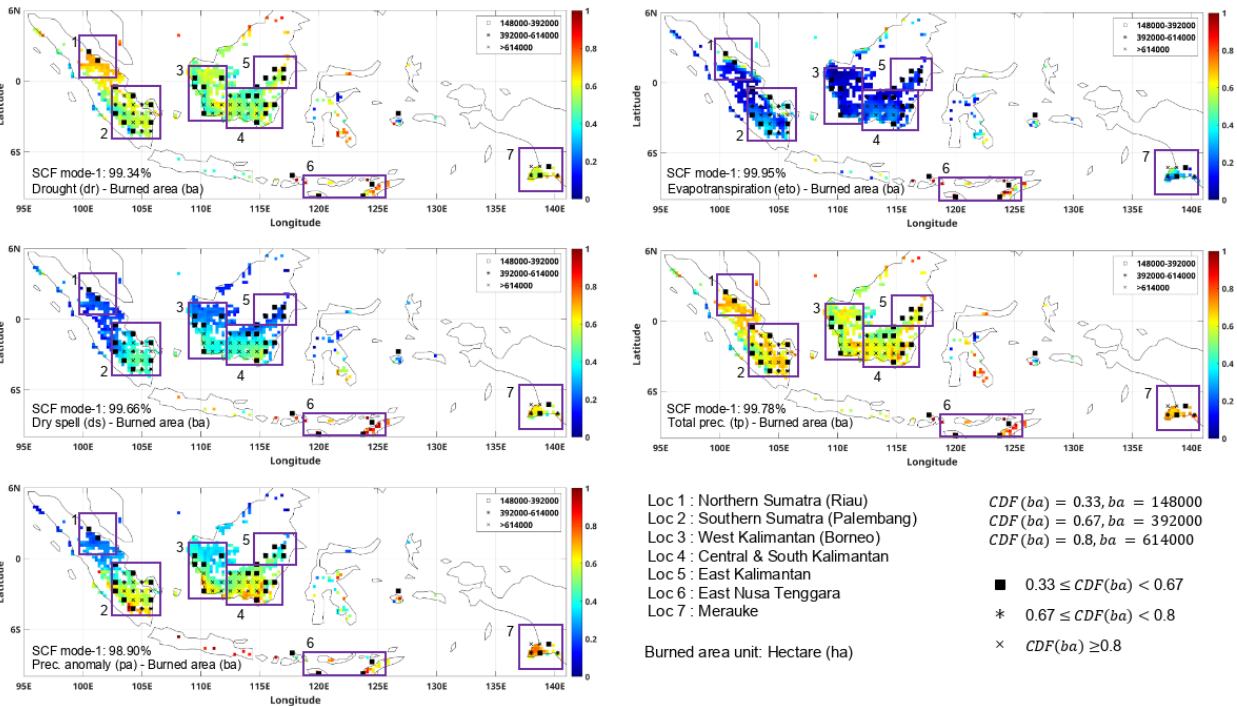
Figure 1. Joint spatial pattern of burned area paired with drought indicators.